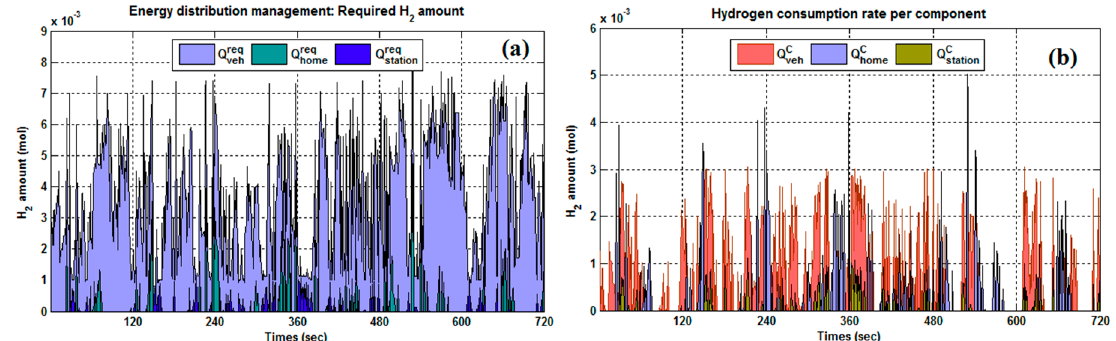
Table 5. H 2 fuel distribution.